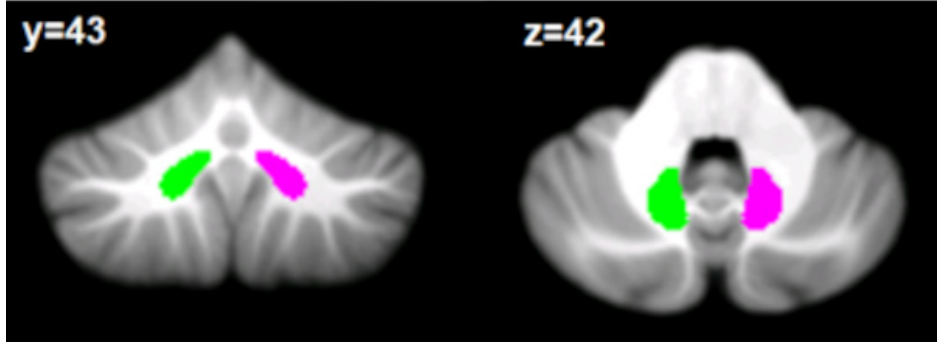
Figure 1. Seed regions in the cerebellar dentate nucleus. Coronal (y) and axial (z) view of the generated left (green) and right (violet) dentate nucleus superimposed to the spatially unbiased atlas template of the cerebellum and brainstem (SUIT, [49]).